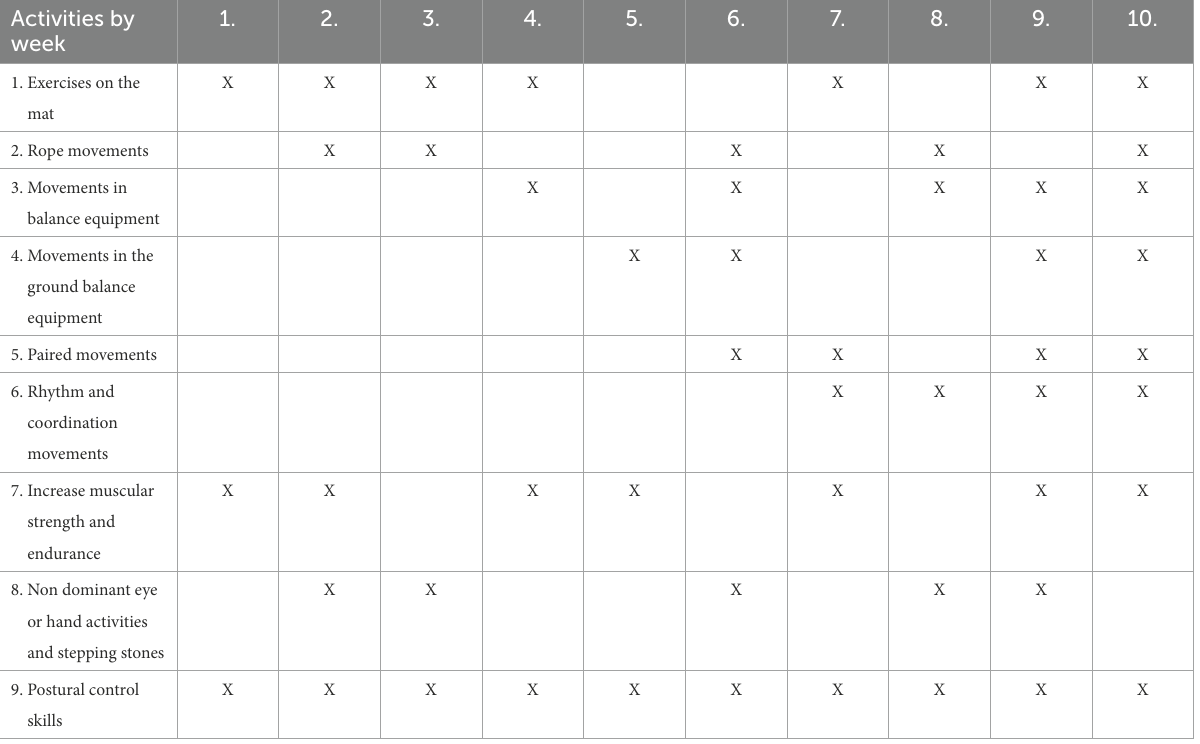
TABLE 2 Exercises with the experimental group and their